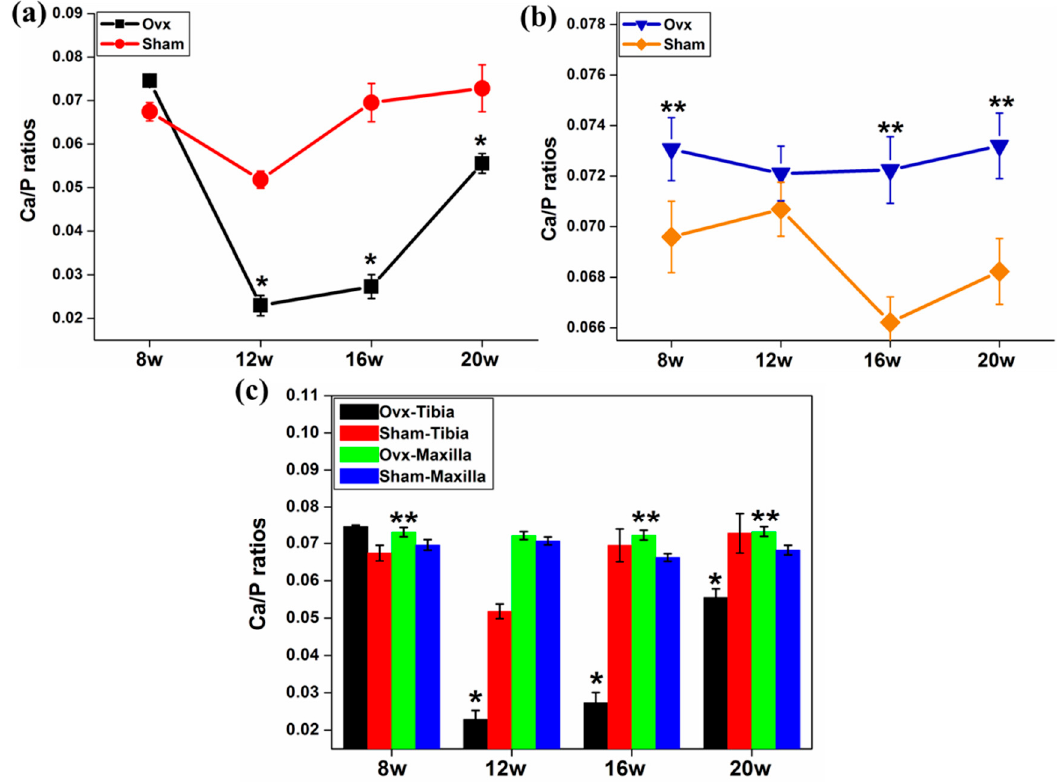
Figure 1. Ca/P ratios in tibia and maxilla. ( a ) The Ca/P ratios decreased dramatically in the Ovx-tibia at 12 weeks but recovered towards week 20; ( b ) There was an increasing trend of Ca/P ratios in the Ovx-maxilla compared to the samples from the sham group; ( c ) Tibial bones from the Ovx rats had lower Ca/P ratios compared to the maxilla from the same animals. The Ca/P ratios remained unchanged in the Ovx-maxilla (the ratios were normalised against matrix-matched reference materials). *: Significant difference ( p < 0.05) between Ovx-tibia and Sham-tibia; **: Significant difference ( p < 0.05) between Ovx-maxilla and Sham-maxilla.